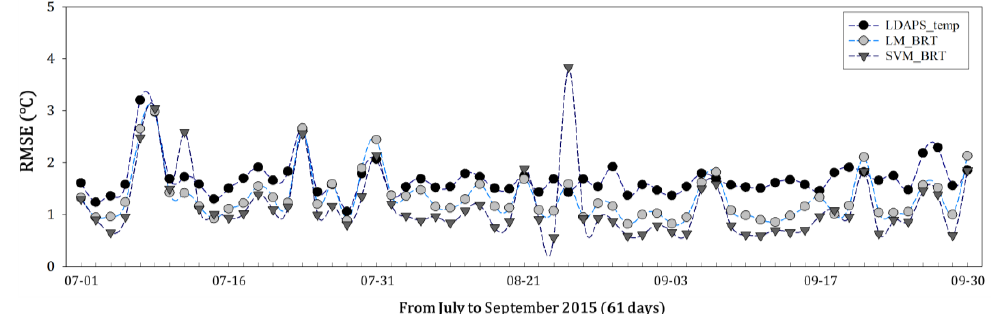
Figure 10. Time series of the root-mean-square error (RMSE) of the estimated Local Data Assimilation and Prediction System (LDAPS; black dots), LM_BRT (linear regression model; gray dots), and SVM_BRT (support vector machine; gray triangles) at 52 KMA AWS sites in Seoul during July to September 2015.